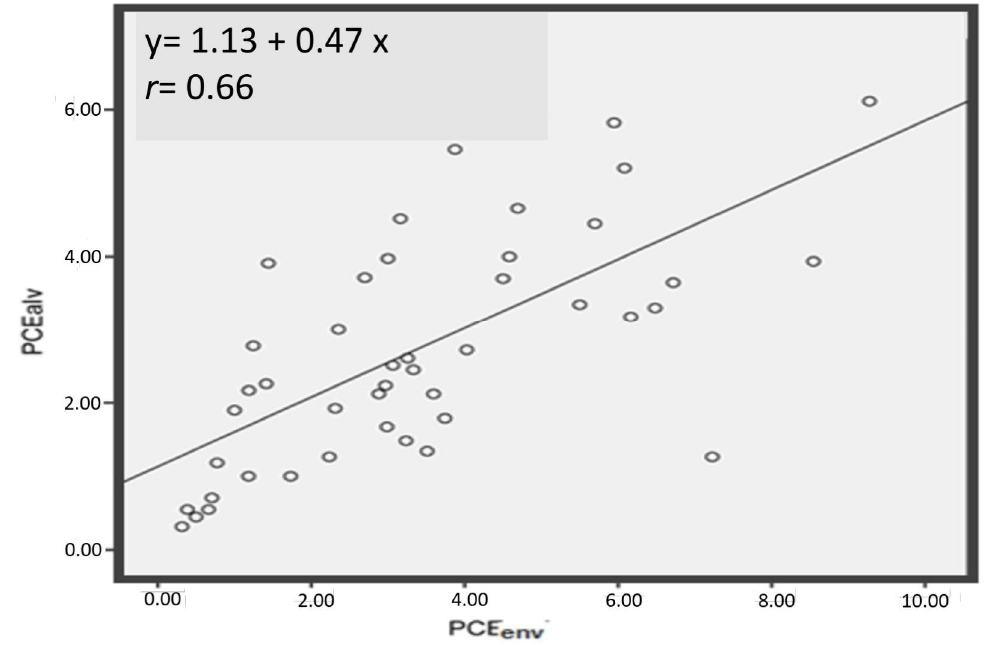
Figure 2. Correlation between environmental PCE concentration in the proximity of workers’ airways (PCE env , after square root transformation) and PCE concentration in the exhaled alveolar air at the end of the work shift (PCE alv , after square root transformation). The regression line equation and the Spearman r coefficient are also reported.